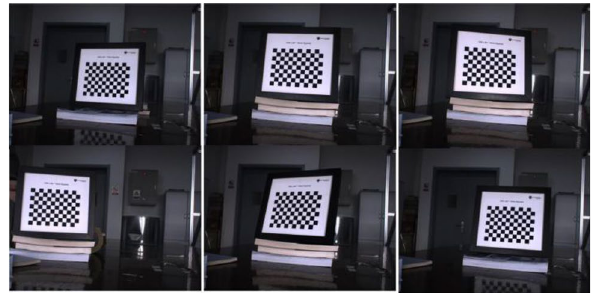
Figure 7. Pictures collected by the camera.